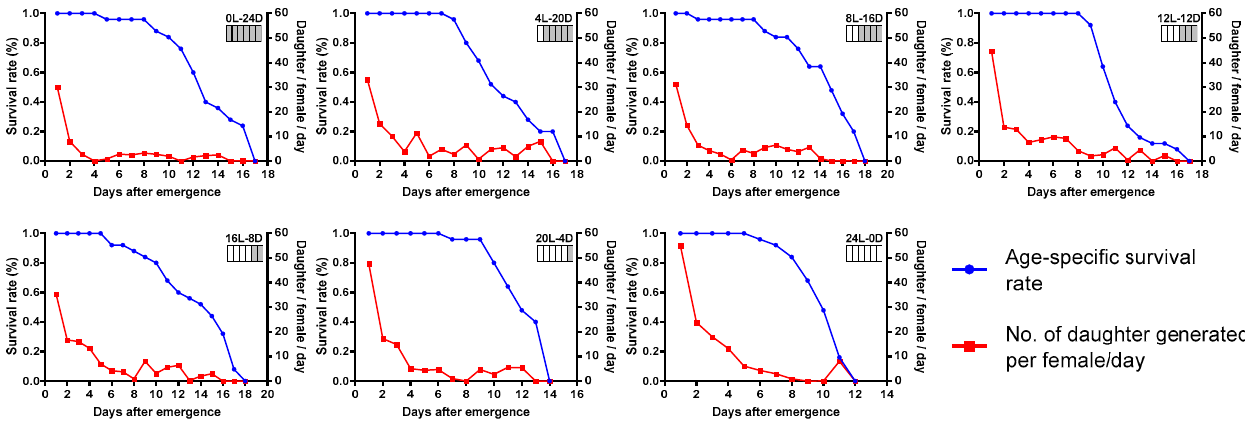
Figure 3. Age-specific survival rate of T. remus and number of daughters generated per female per day under different photoperiods.